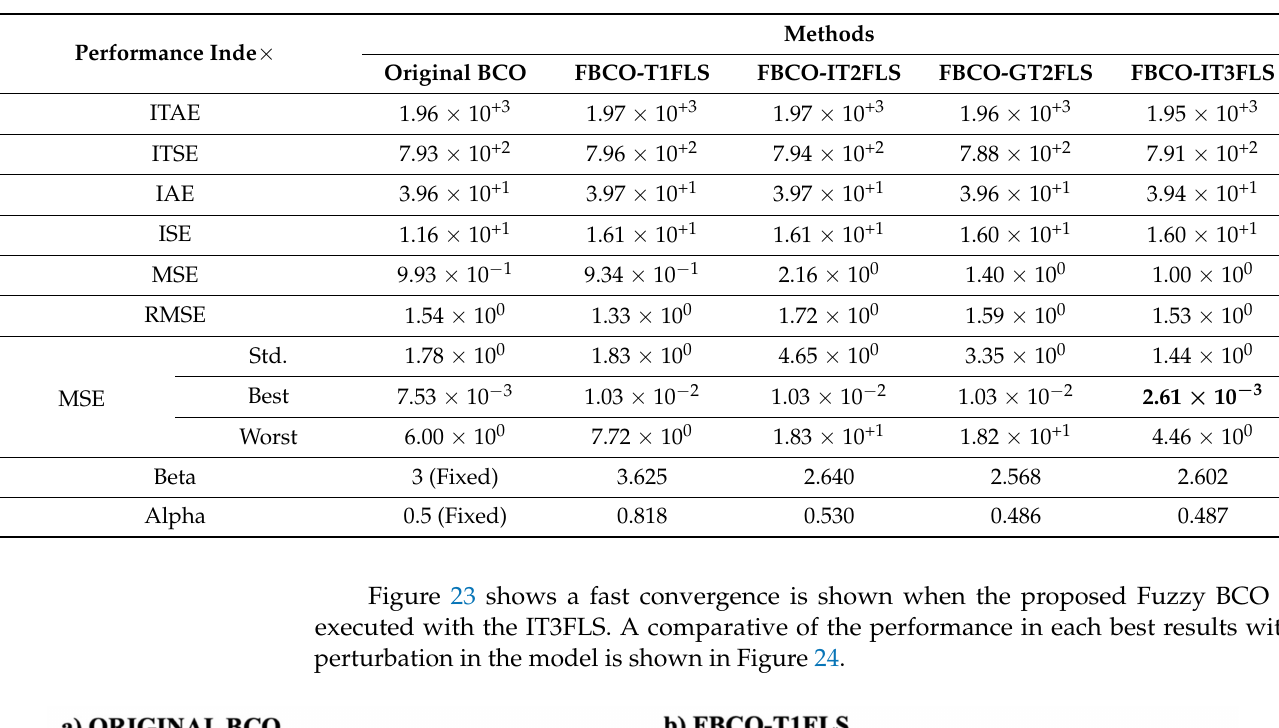
Table 2. Simulation errors for each Fuzzy BCO algorithm with perturbation.